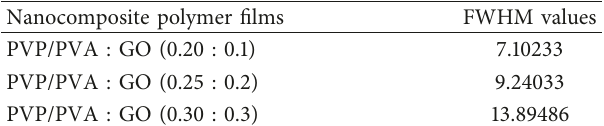
Table 1: FWHM values of PVP/PVA : GO nanocomposite polymer films. Nanocomposite polymer films